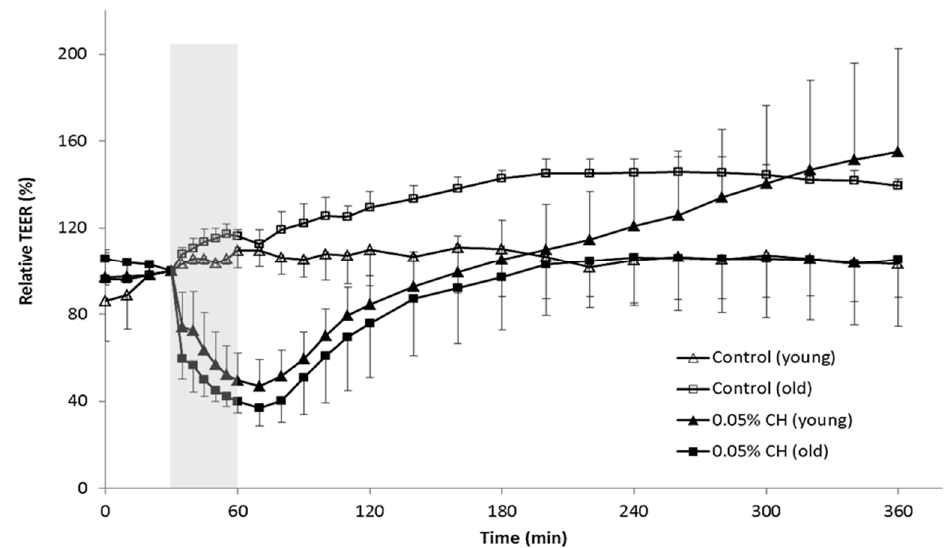
Figure 1. Transepithelial electrical resistance (TEER) values of urinary bladders of young and old mice measured in ex vivo experiments (mean and standard deviation). During the treatment period (grey shaded area), the urothelium was exposed to 0.05 % w / v dispersion of chitosan (CH) with a pH of 4.5 or phosphate buffer saline with a pH of 4.5 (control). Altogether, the isolated urinary bladders of 5 young and 5 old animals were used; for each age group, four urinary bladder halves in control experiments and six urinary bladder halves in the experiments with chitosan.